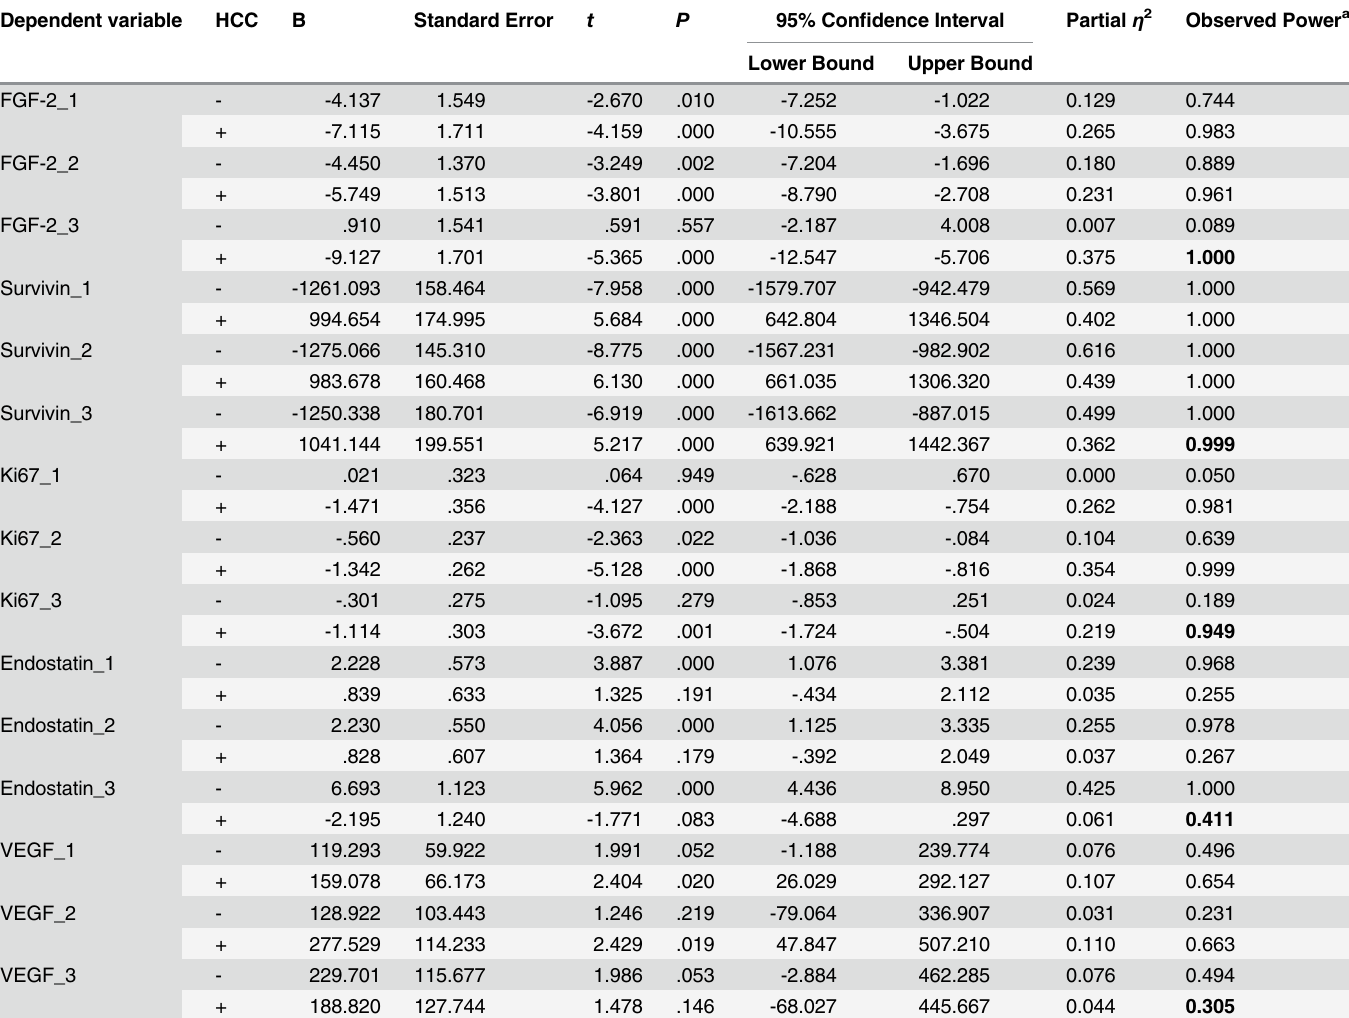
Table 2. Observed power of hepatocellular carcinoma biomarkers in living donor liver transplantation. Dependent